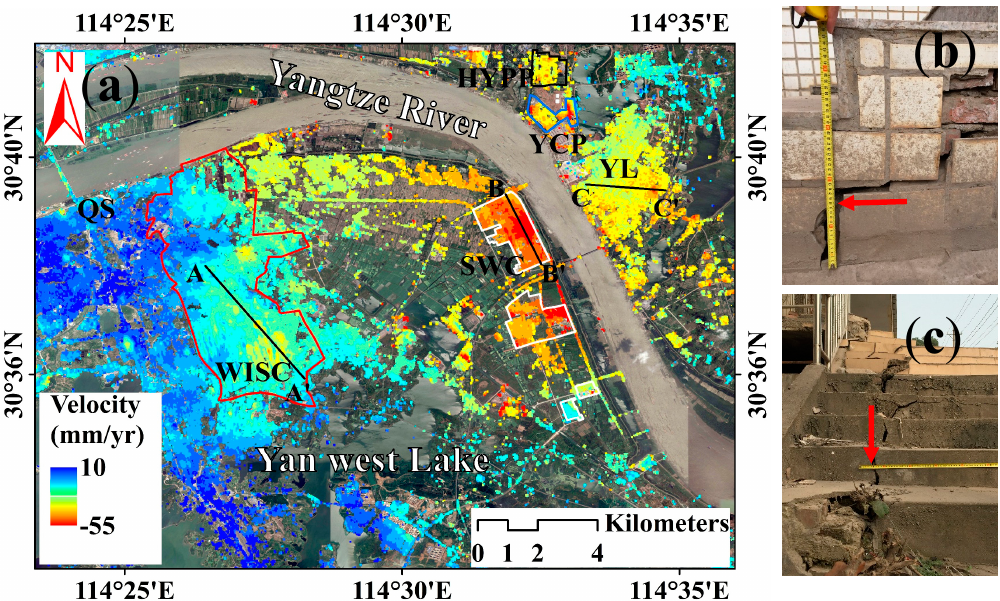
Figure 10. Surface vertical deformation rate map superimposed on Google Earth image covering ( a ) Region S2. Red, white, blue and black polygons denote the industrial areas of WISC, SWC, YCP, and HYPP, respectively. Black lines represent subsidence profiles that will be further analyzed in the Section 5.3. ( b , c ) Structural damage due to surface subsidence.